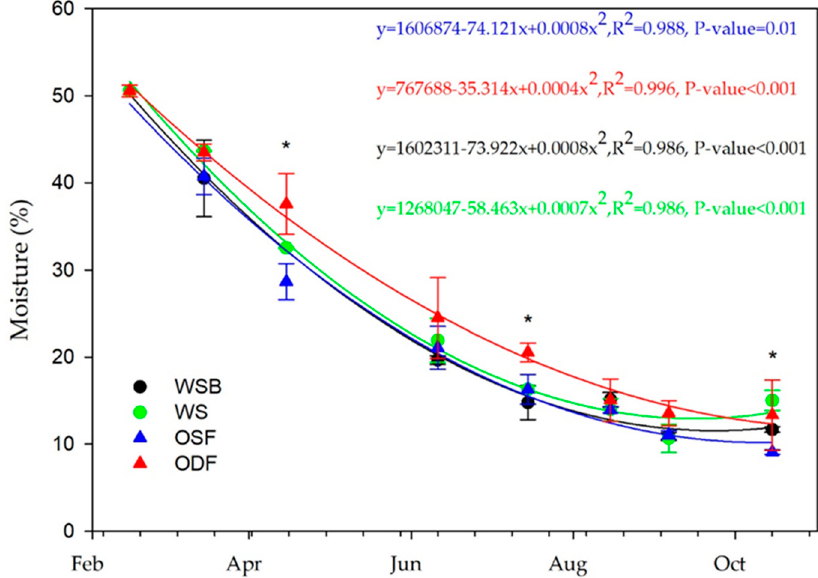
Figure 5. Moisture dynamic during the storage period. WS is the outdoor storage of whole stems without branches; WSB is the outdoor storage of whole stems with branches; OSF is the open shed storage of firewood logs in mesh bags; ODF is outdoor firewood logs in mesh bags (ODF). Differences between the storage methods in sampling date are indicated with *. Bar error represents standard deviation.